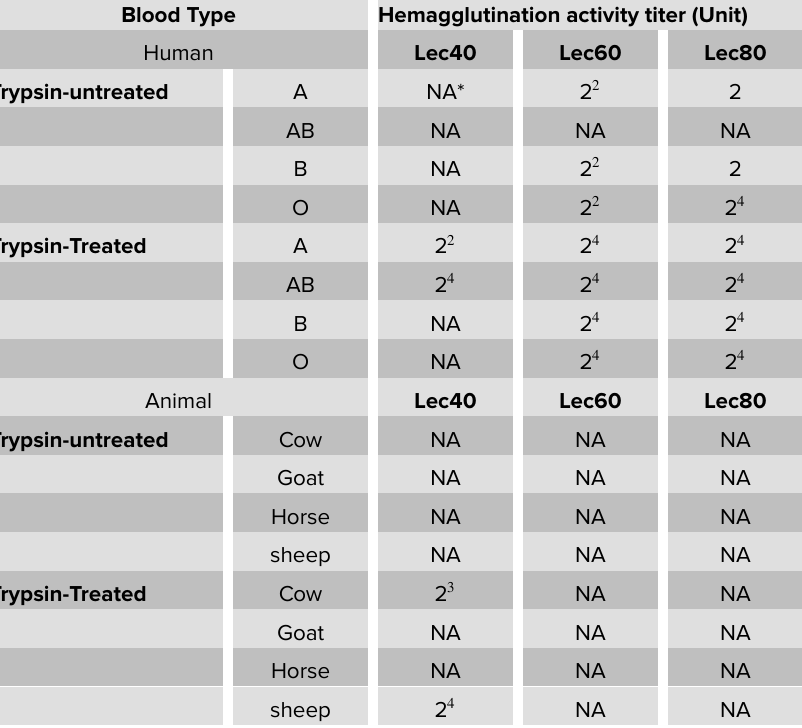
Table 3: Agglutination study of lec40, 60 and 80 of Jatropha curcas with human and animal erythrocytes. Blood